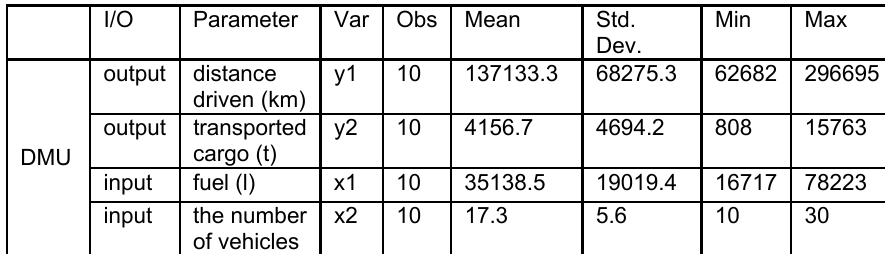
Table 3 – Descriptive input and output statistics for transport